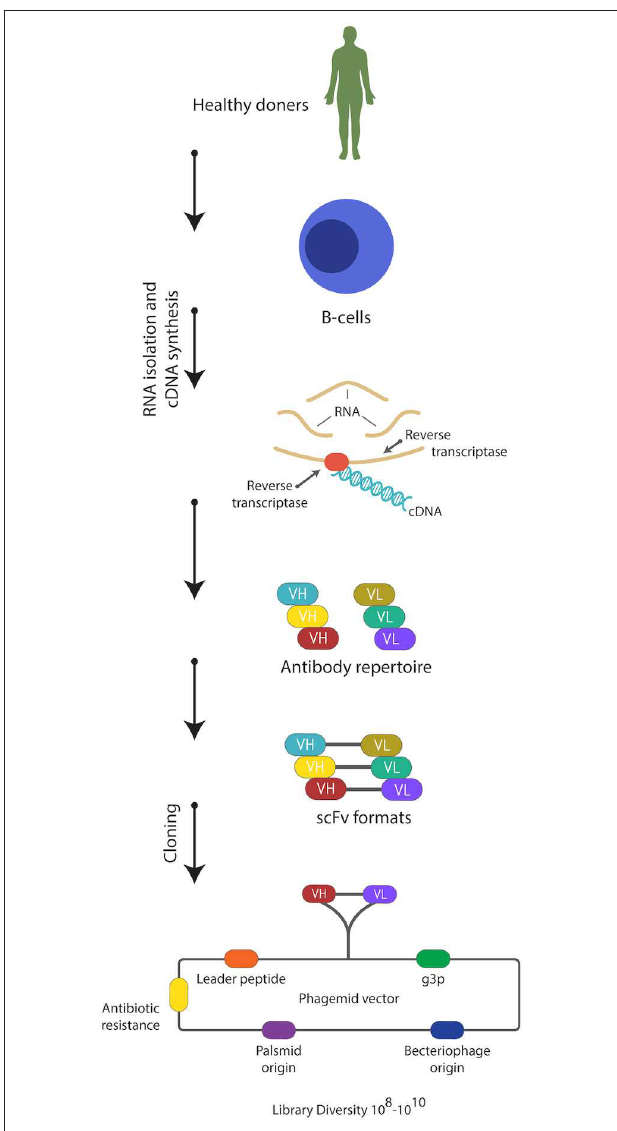
FIGURE 2 | Strategy used for construction of naïve scFv-phage display libraries. Total RNA is isolated from B-lymphocytes from non-immunized healthy donors. Then cDNA is synthesized from the isolated RNA using reverse transcriptase enzyme. Then the repertoire of the V H and V L genes is amplified from the cDNA using forward and reverse primers hybridizing to the variable domains. scFvs are constructed and cloned into phagemid vector and a naïve phage library of 10 8 -10 10 is usually